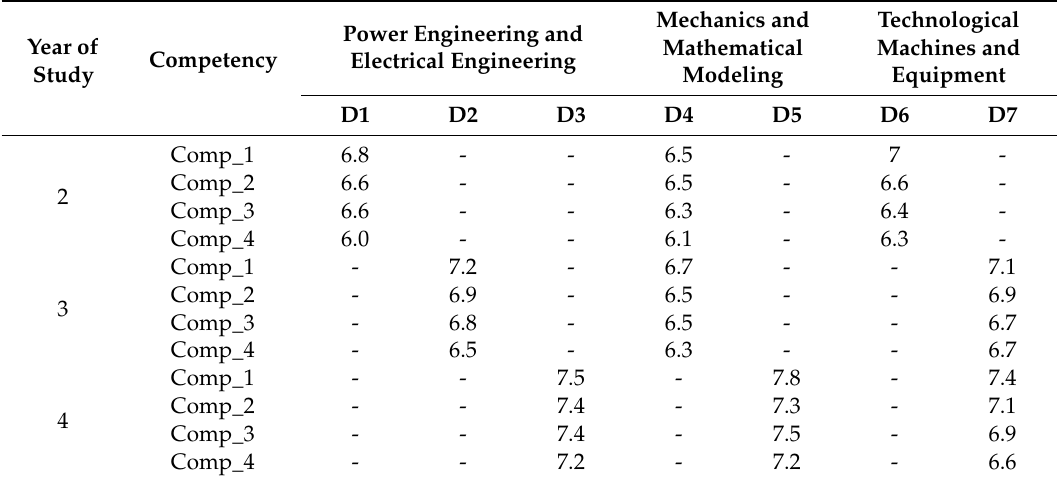
Table 2. Average values of the level of the formed students’ professional